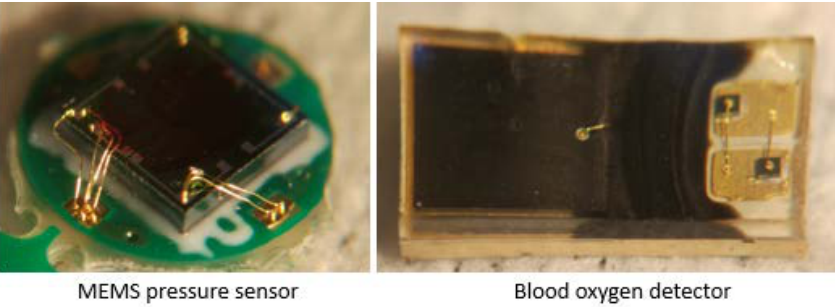
Figure 5. The blood oxygen detector and the packaged MEMS pressure sensor.